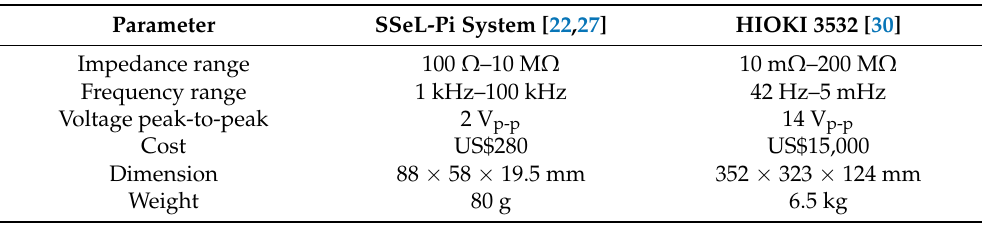
Table 1. Raspberry Pi platform impedance monitoring system ‘SSeL-Pi’ versus commercial impedance analyzer ‘HIOKI-3532’.